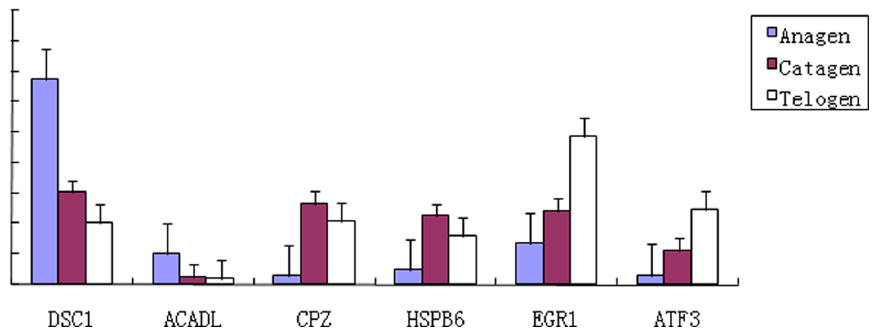
Figure 6. The qPCR validations of DEGs characterised by RNA-Seq. The results verified that these genes were differentially expressed at different hair follicle developmental stages, consistent with the RNA-Seq findings.